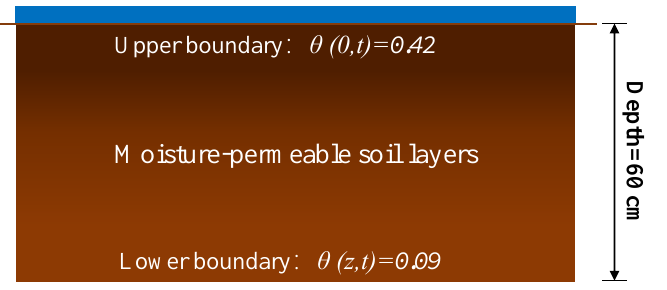
Figure 4. Schematic diagram of the boundary conditions for soil–water infiltration during validation.